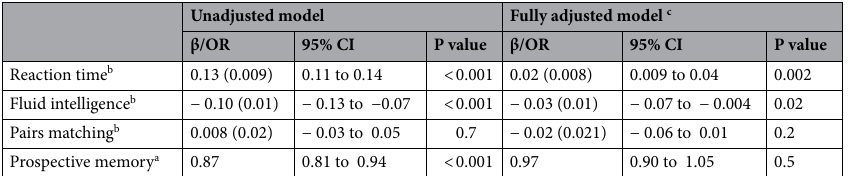
Table 4. Regression models for the association between RA and cognition. a Logistic regression with OR. b Linear regression with standardized betas and SE. c Adjusted for the covariates of age, sex, ethnicity (White British vs Other), deprivation index, smoking status, BMI and alcohol